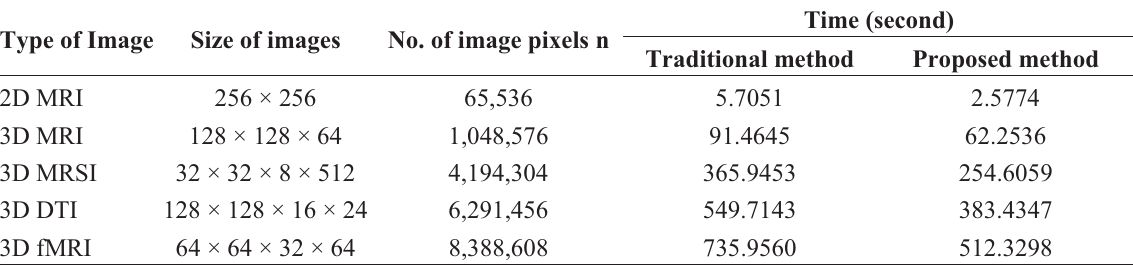
Table 1. Comparison of computation times image reconstruction by the conventional and the proposed methods for different MR modalities ( c = 8, r =